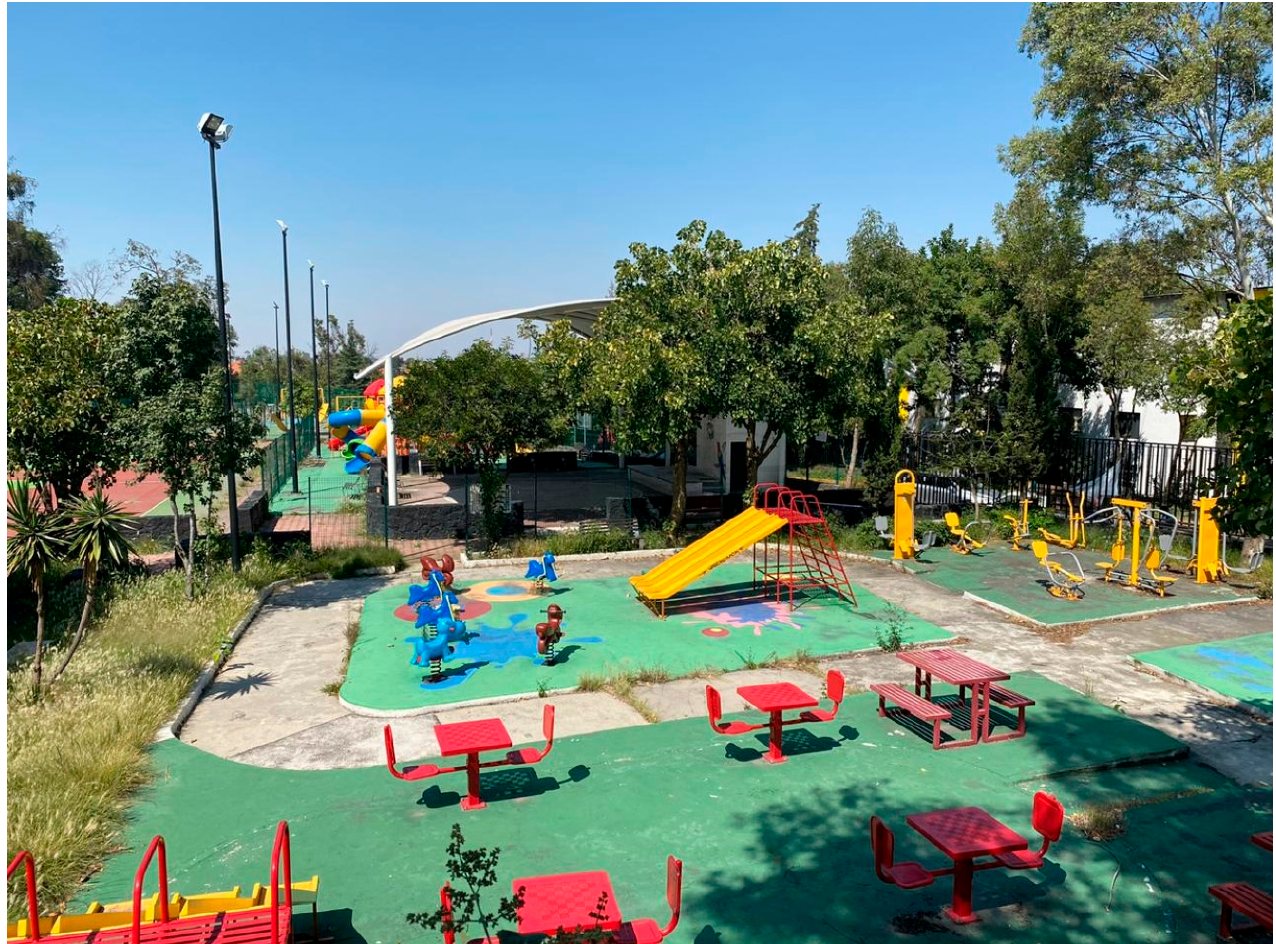
Figure 1 . Park near Participant 5’s home. The area was recently renovated by neighbors and closed due to COVID ‐ 19 restrictions.